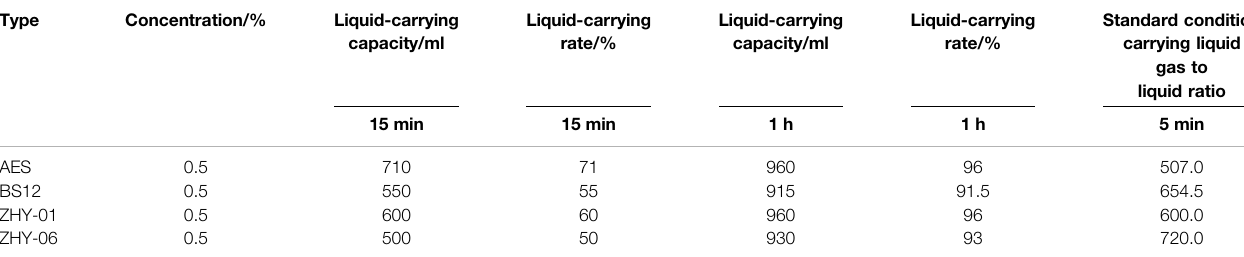
TABLE 2 | Liquid-carrying capacity of different foaming agents at 0.5%